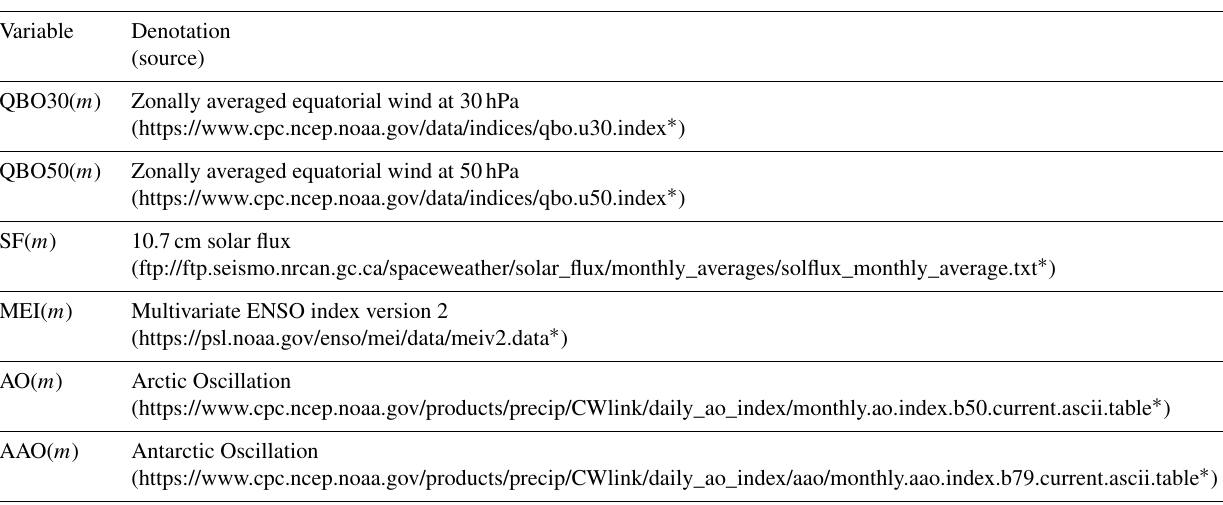
Table 2. Sources of explanatory variable time series used in the MLR (Eq. 1). Figure A1 shows the time series (normalized to zero mean and unit variance) for all individual covariates.